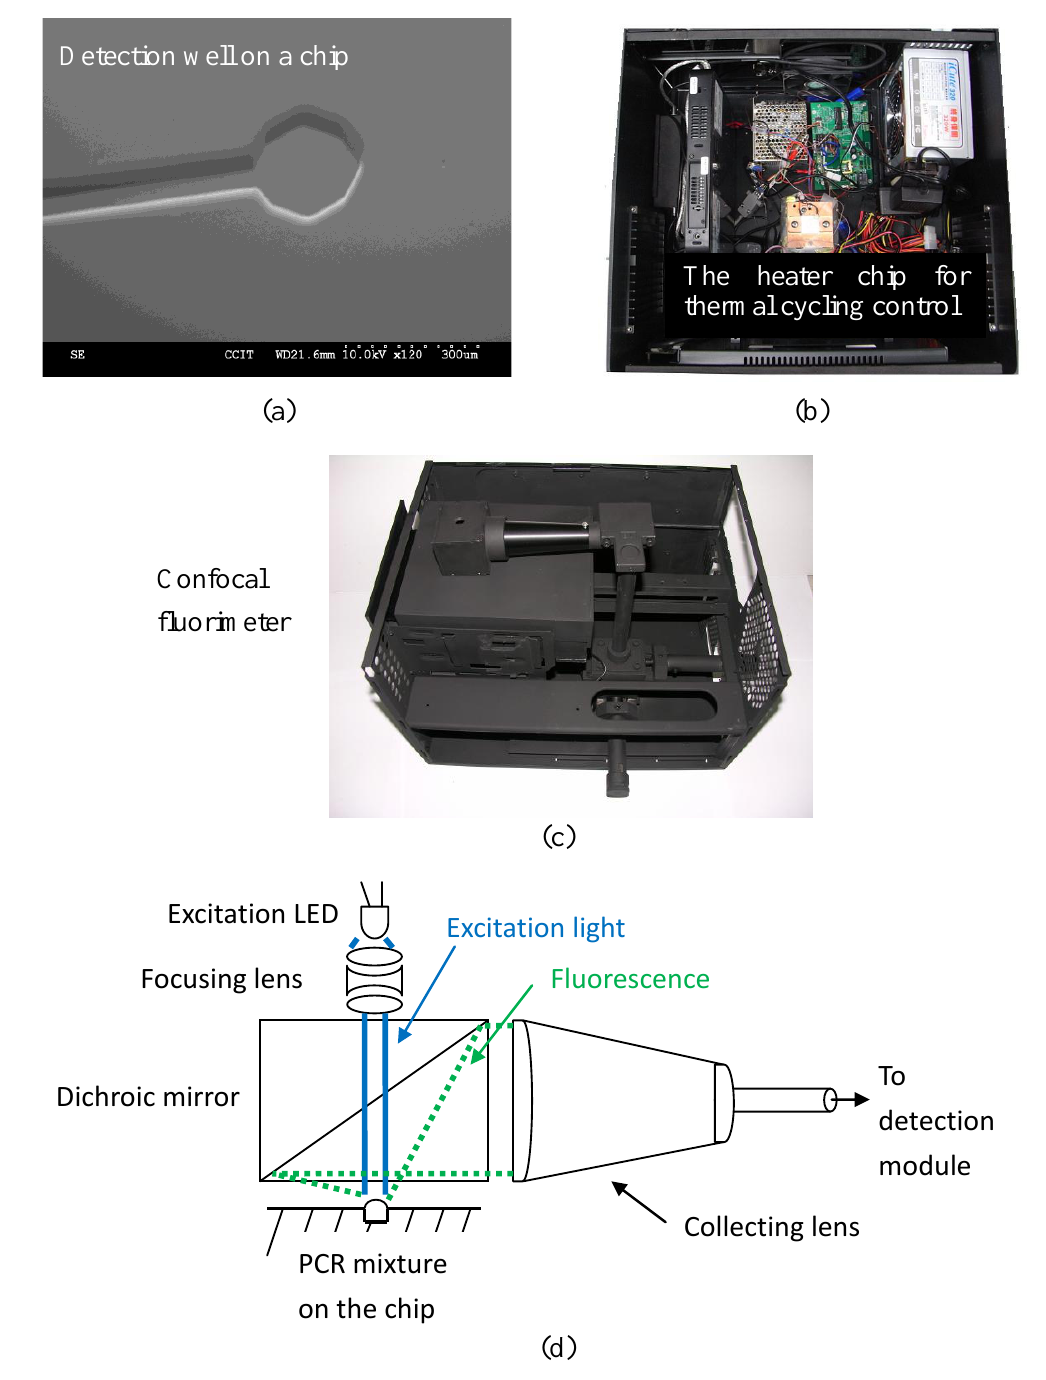
Figure 2. Schematic view of the confocal fluorimeter design for real-time PCR on a